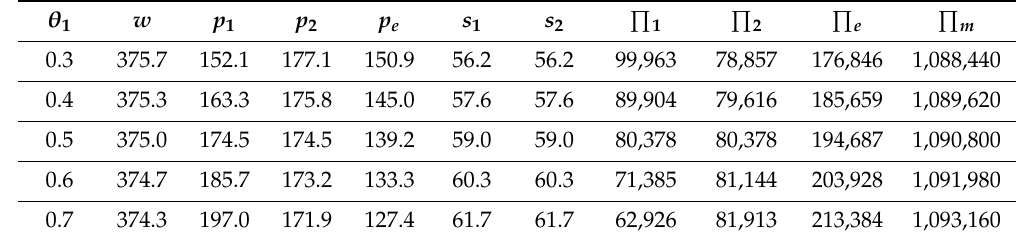
Table 3. The e ff ect of θ 1 on decisions by applying strategy S2.